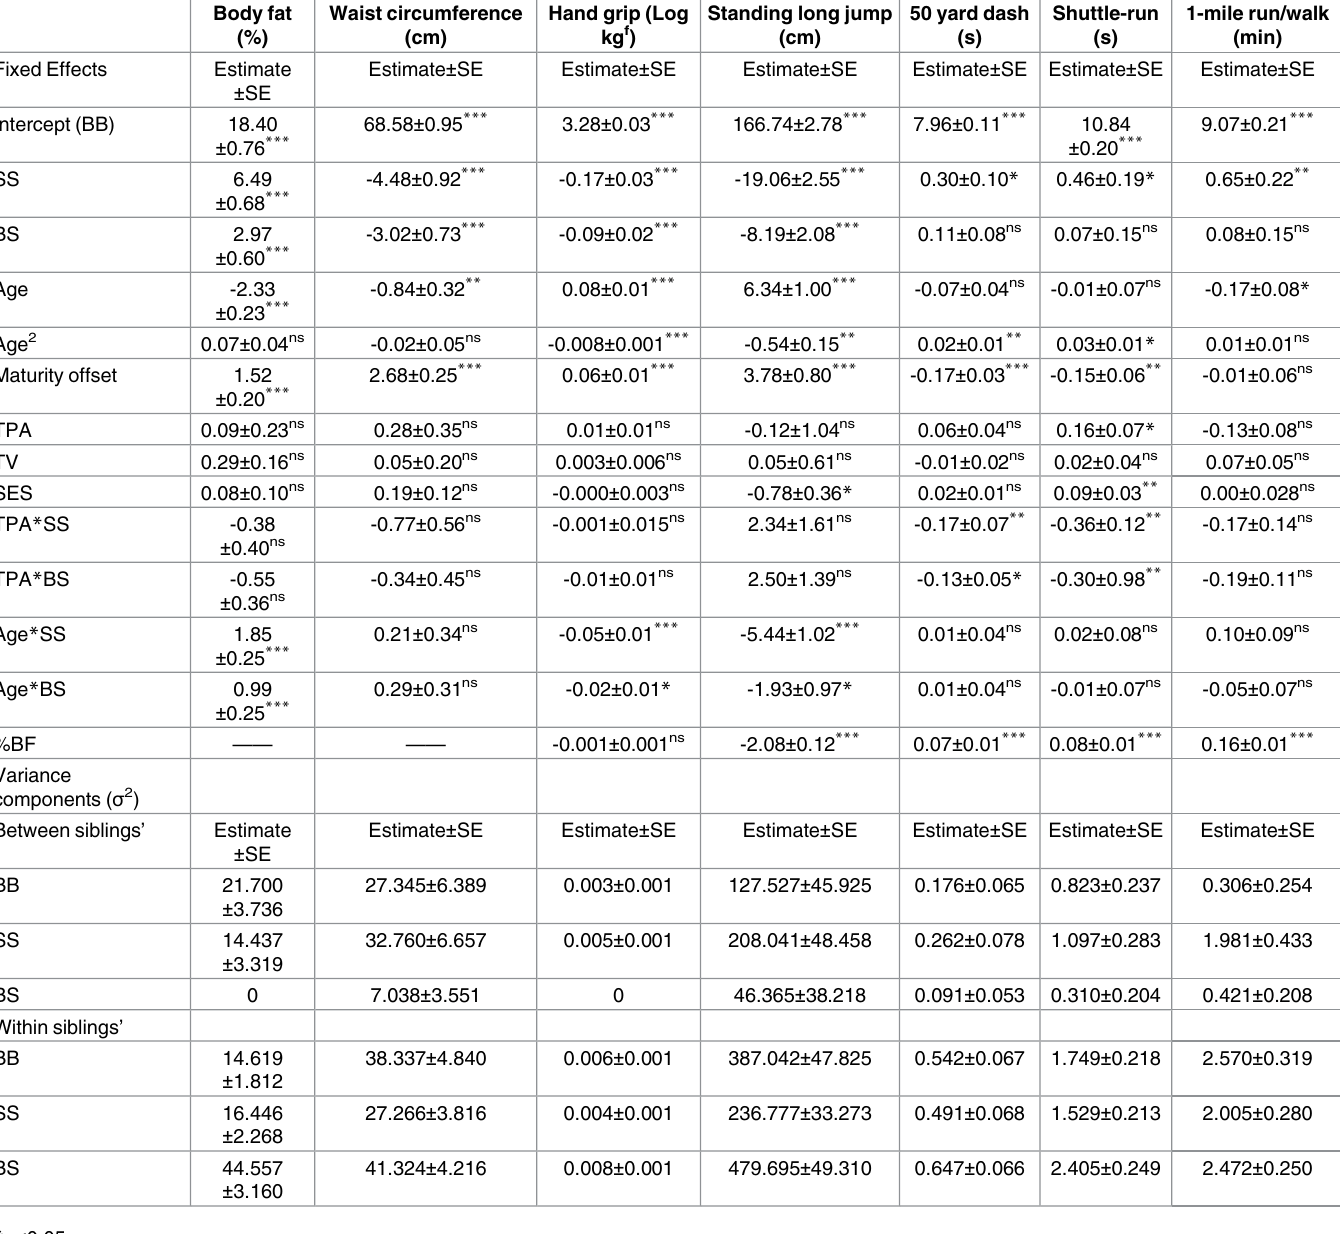
Table 2. Parameterestimatesand variance components for each physical fitness